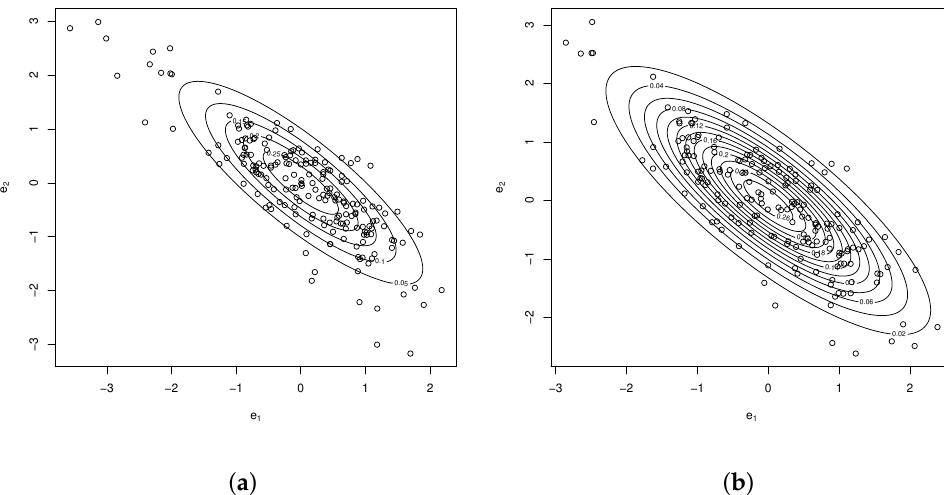
Figure 4. Contour plot of the bivariate vector ( e i 1 , e i 2 ) : ( a ) with outliers and ( b ) without